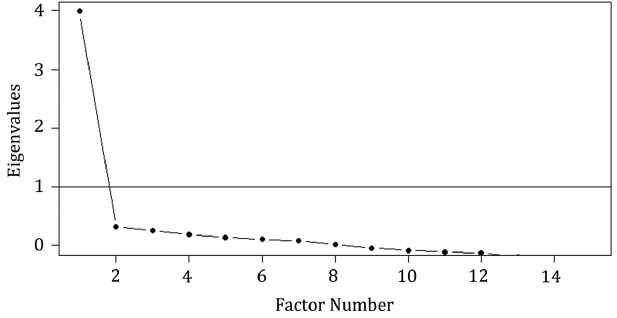
FIG. 4. Scree plot from EFA for the U-STEP showing a clear elbow after the first factor. A horizontal line is shown for an eigenvalue of 1, as it is suggested to only keep factors with eigenvalues greater than